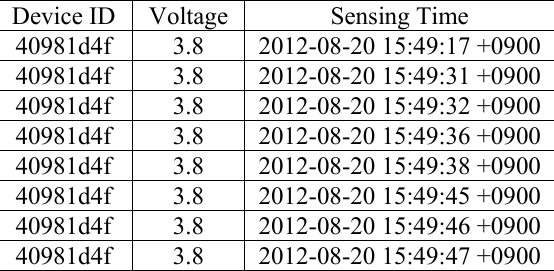
Table 1: Example of actual sensing